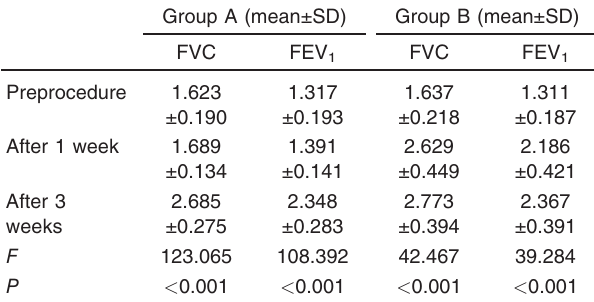
Table 3 Spirometric changes in groups A and B before and after each procedure